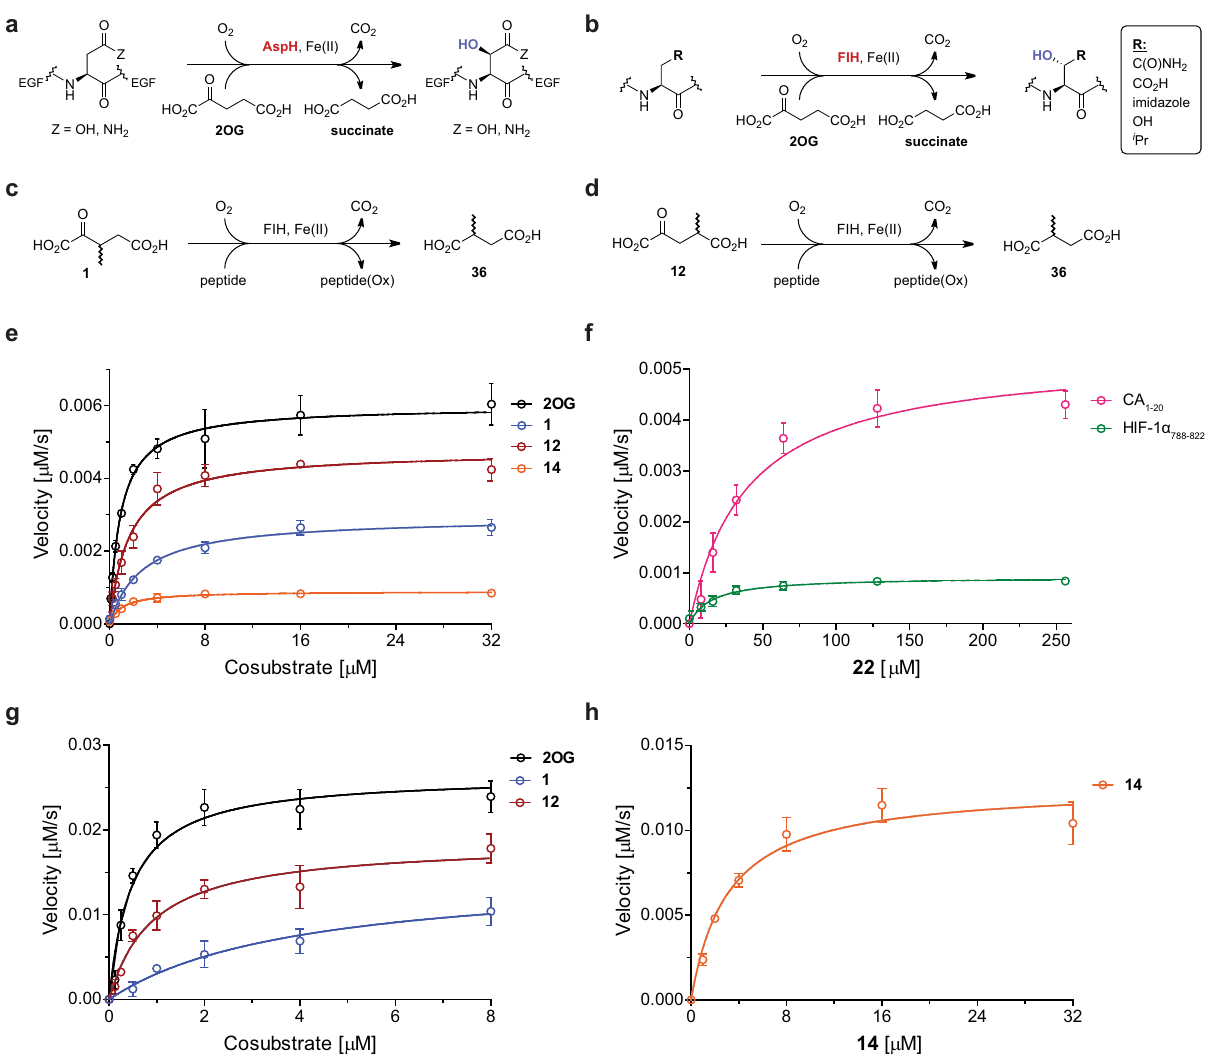
Fig. 1 Comparison of AspH and FIH catalysis and steady-state kinetic parameters for FIH-catalyzed oxidative decarboxylation of 2OG derivatives from initial hydroxylation rates. a AspH and b FIH catalyze the post-translational C3 hydroxylation of Asn- and Asp-residues. FIH also catalyzes the oxidation of other residues, i.e., His-, Leu- and Ser-residues 41,42 ; c and d FIH catalyzes the oxidative decarboxylation of c 3-methyl-2OG ( 1 ) and d 4-methyl-2OG ( 12 ) to give 2-methylsuccinate ( 36 ); e K app m of FIH for 2OG (black), 1 (blue), 12 (red), and 14 (orange) using HIF-1 α 788 – 822 as a substrate; f K app m of FIH for 22 using HIF- 1 α 788 – 822 (green) or CA 1 – 20 (pink) as a substrate; g K app m of FIH for 2OG (black), 1 (blue), and 12 (red) using CA 1 – 20 as a substrate; h K app m of FIH for 14 (orange) using CA 1 – 20 as a substrate. FIH assays were performed as described in the Methods section, data are shown as the mean of three independent runs ( n = 3; mean ± standard deviation, SD). The peptide hydroxylation rates are shown in Supplementary Figs. 5 and 6, source data are provided as a Source Data fi